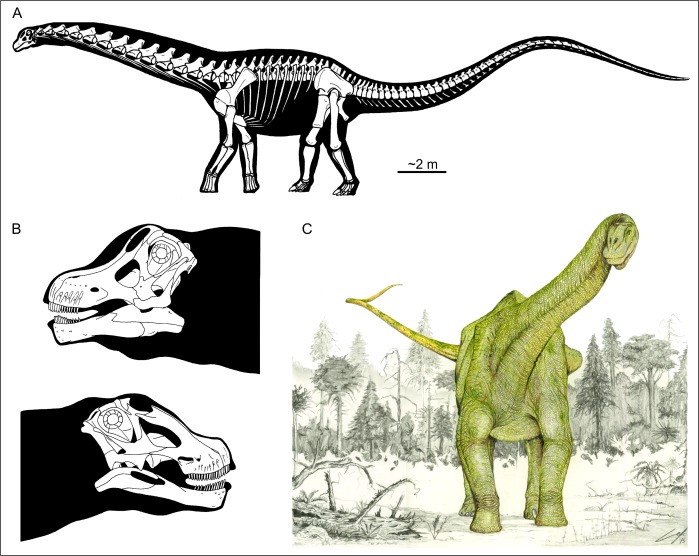
Skeletal and life restorations of titanosaur sauropods.(A, C) Based on Futalognkosaurus dukei (Calvo et al., 2007). (B) Skull reconstructions of (up) Nemegtosaurus mongoliensis, Nowinski 1971 and (down) Tapuiasaurus macedoi
Zaher et al., 2011 (based on Wilson, 2005b and Zaher et al., 2011, respectively).